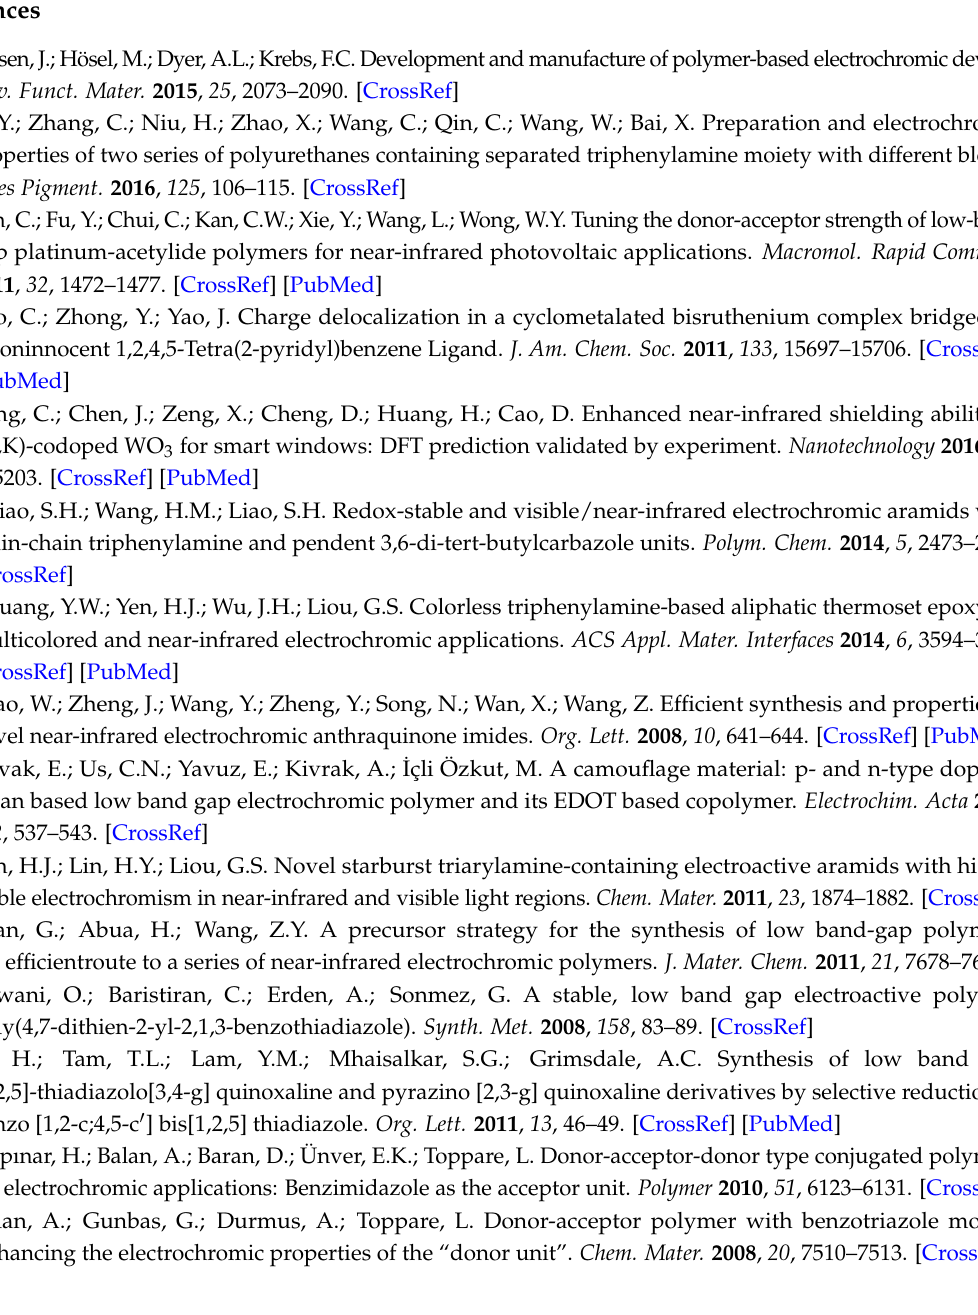
Figure S7: (a) 1 H NMR spectrum of M4 in CDCl 3 . Solvent peak at δ = 7.26 ppm is marked by “x“; (b) 13 C NMR spectrum of M4 in CDCl 3 . Solvent peak at δ = 72.50 ppm is marked by “X“. Figure S8: Cyclic voltammetry (CV) curves of the monomers: (a) M2; (b) M3; and (c) M4. Figure S9: CV curves of the polymers for p-type doping process at various scan rates: (a) P2; (b) P3; and (c) P4. Insert: graphs of scan rate vs. peak current density. Figure S10: The first and the 1000th CV curve of the polymers: (a) P2; (b) P3; and (c) P4. Figure S11: Film thicknesses of the polymers deposited potentiostatically onto ITO electrode: (a) P1; (b) P2; (c) P3; and (d)